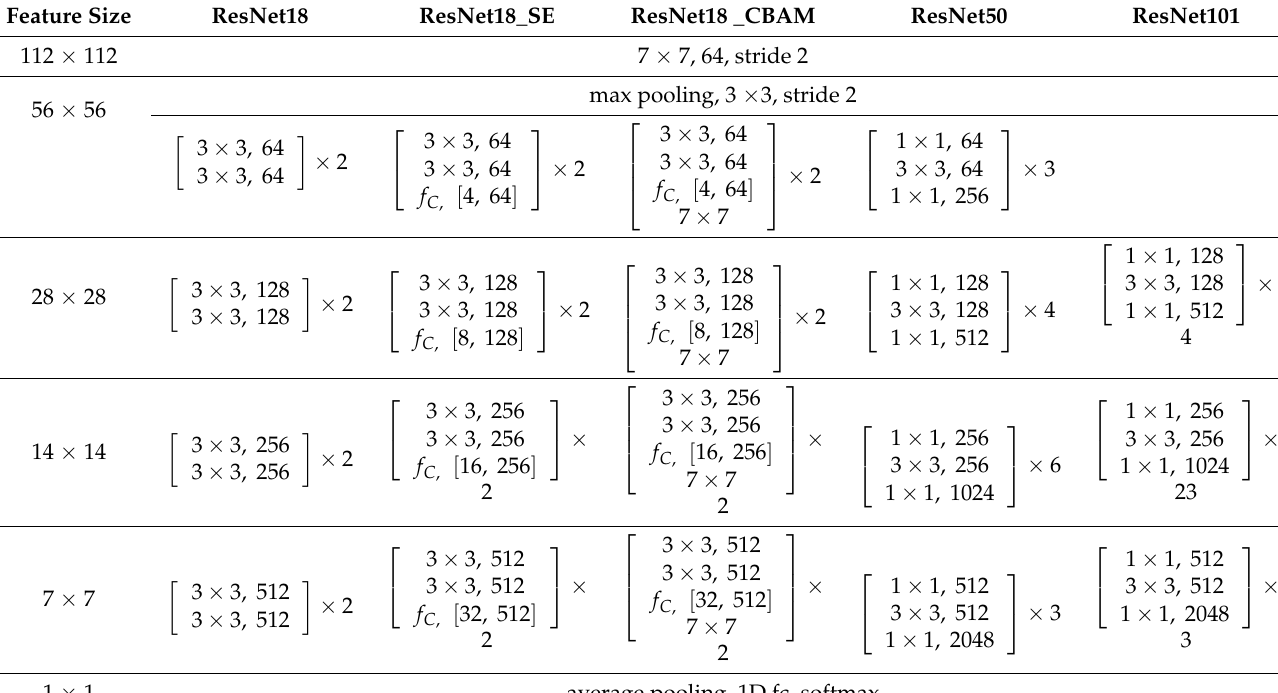
Table 1. The architectures of main backbone